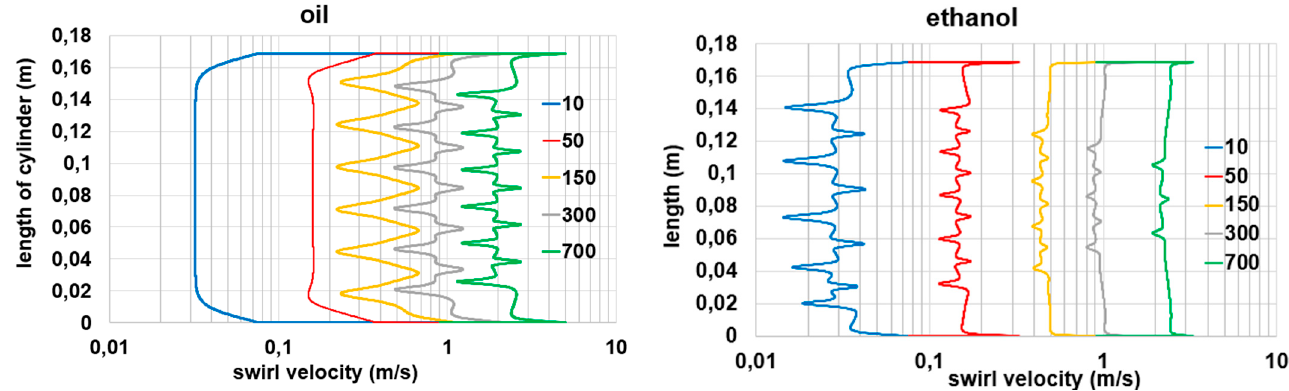
Figure 9. Dependence of the swirl velocity in logarithmic coordinates on cylinder length. Periodic changes along the length of the cylinder copy all the other variables, such as the pressure, strain rate, etc.; see Figure 10.